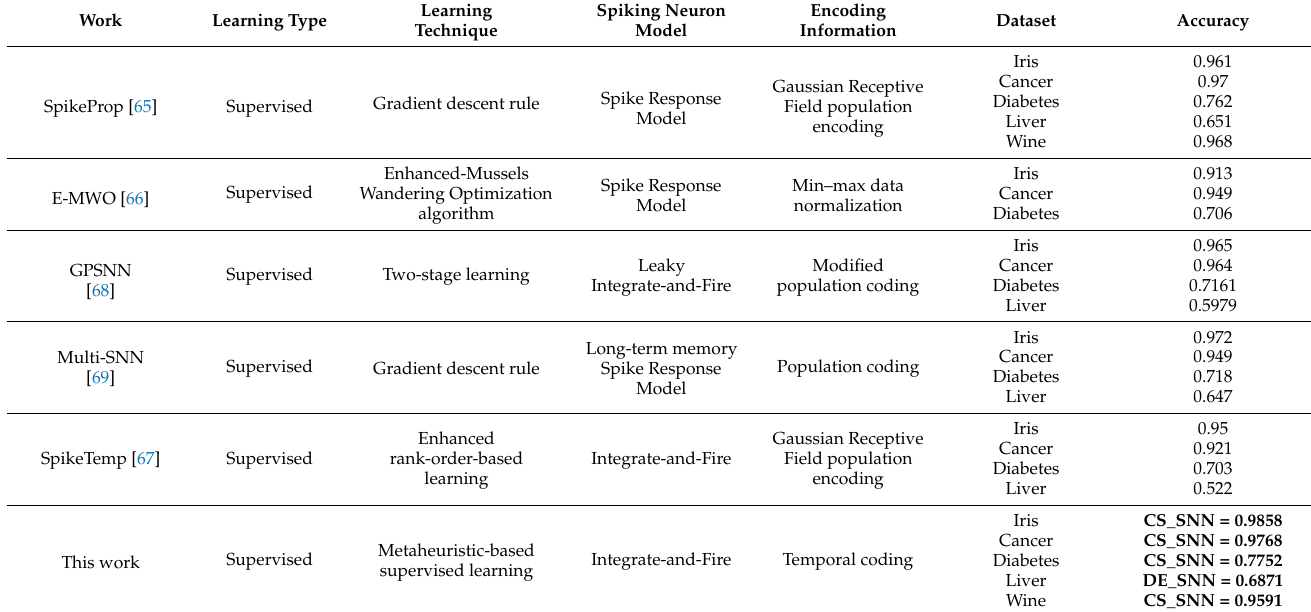
Table 4. Summary of the models for developing supervised SNNs—their learning techniques, neuron models, and encoding strategies, along with their accuracy rates on the UCI